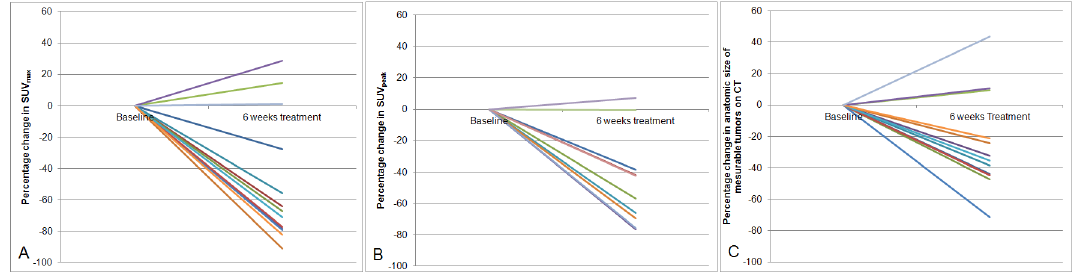
Fig 1. Change in percentage between baseline and after 6 weeks of treatment with crizotinib assessed using SUV max (1A, N = 13), SUV peak (1B, N = 10) and RECIST (1C, N = 13).